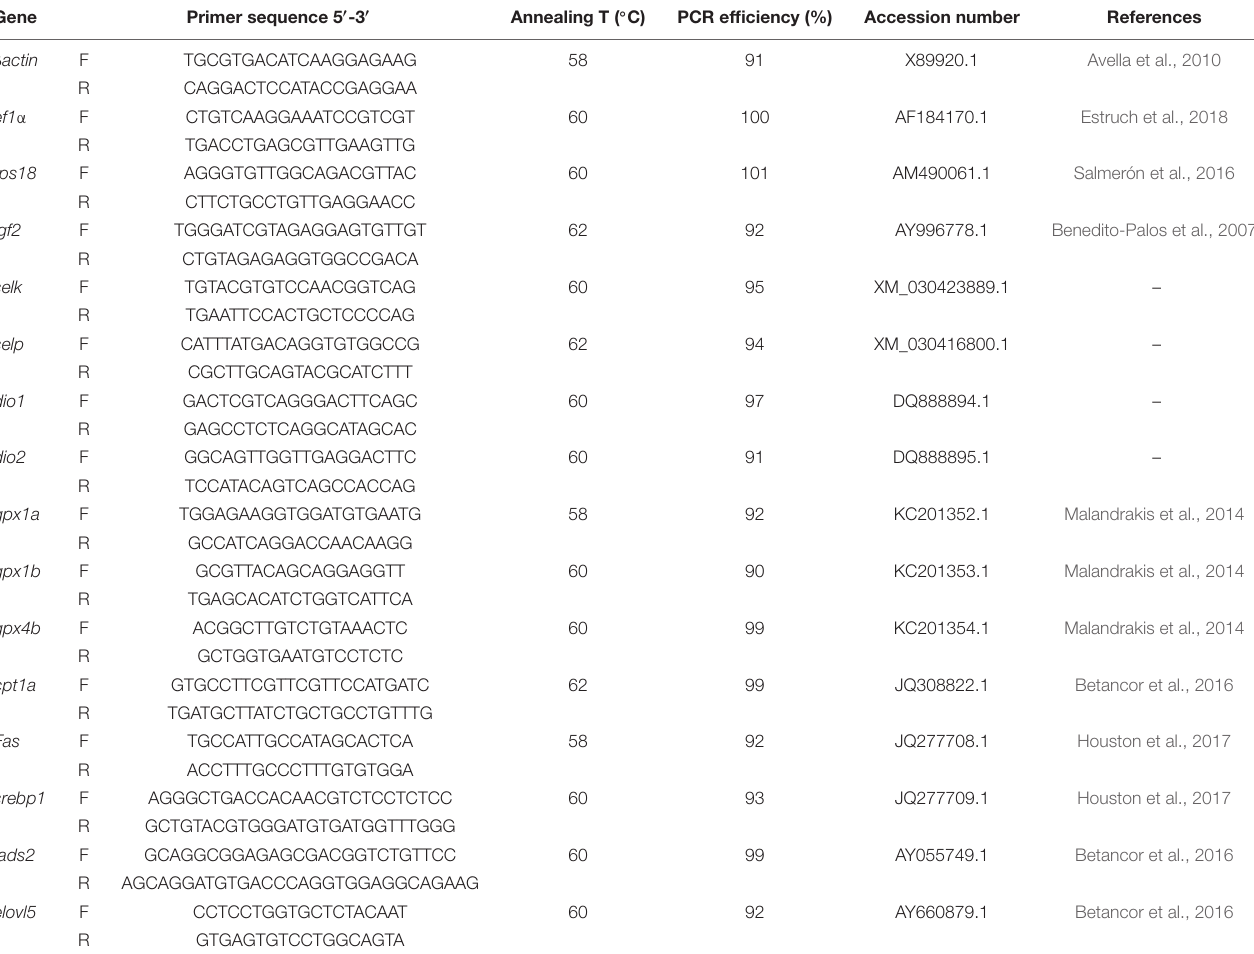
TABLE 3 | Oligonucleotide primers used in the reverse transcription-qPCR analysis and respective annealing temperature ( ◦ C), PCR efficiency (%), accession number and reference. Gene Primer sequence 5 (cid:48) -3